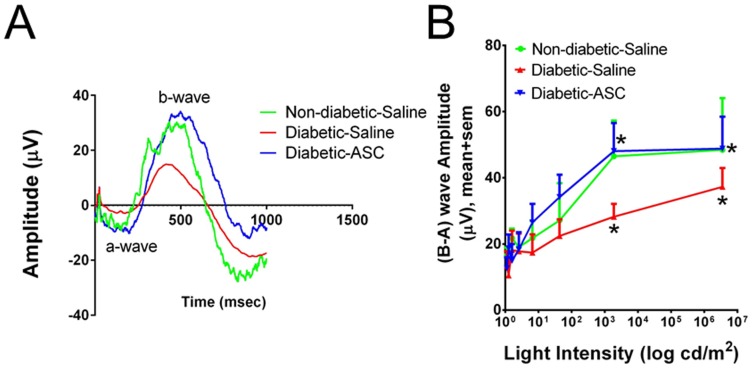
Intravitreal injection of ASC improves retinal function in the diabetic athymic nude rat.Two months post diabetes induction ERG was recorded in anesthetized rats at day 6 with saline and ASC injections and compared with non-diabetic rats that received saline injections. A representative ERG waves from dim flash to bright flash over time is computed (A). Notable differences in b-wave observed in diabetic animals compared to non-diabetic group, which was near completely normalized with ASC. The b-wave amplitudes computed against different light intensities (B) revealed a significant (*p<0.05) decrease in amplitude at high intensities in diabetic rats that received saline compared to non-diabetic rats that received saline. Interestingly, the decrease in amplitude is significantly (*p<0.05) alleviated with ASC at day 6 compared to diabetic rats that received saline. The data shown is from a group size of n = 6–8 animals.